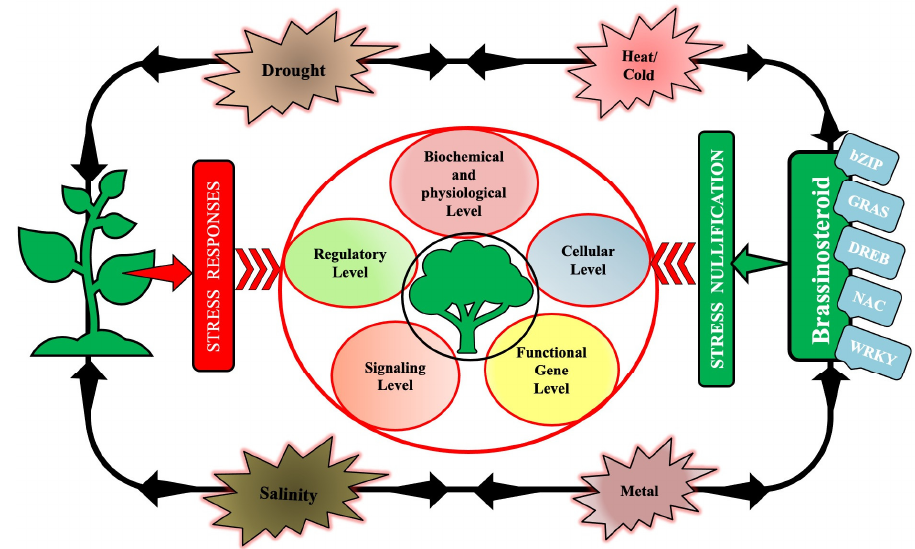
Figure 3. A vivid picture of the numerous mechanisms endorsed by the Brassinosteroids at different levels in plants to mitigate a plethora of potentially fatal abiotic stresses with close association with transcription factors.